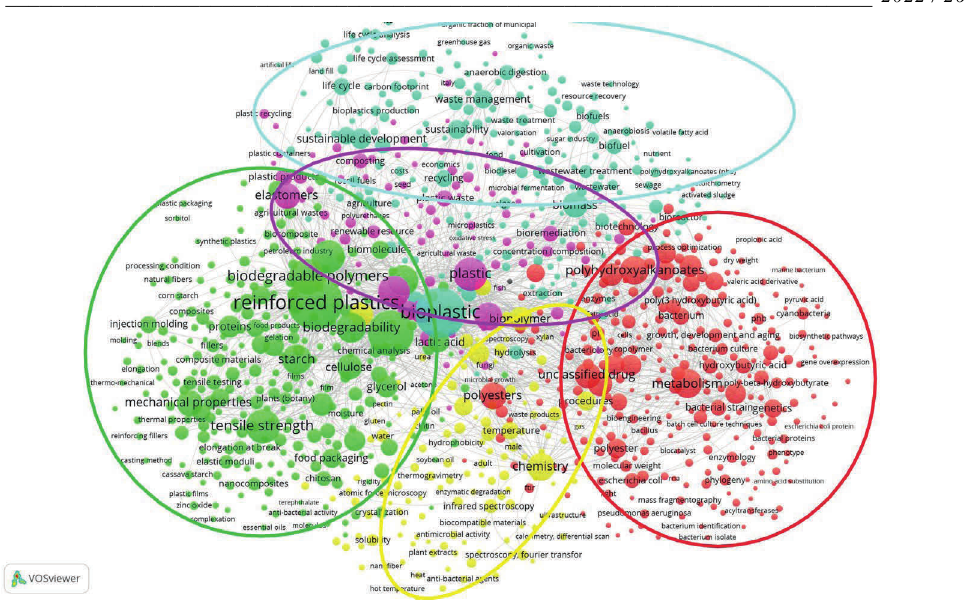
Fig. 4. Visualization of co-occurrences for keyword